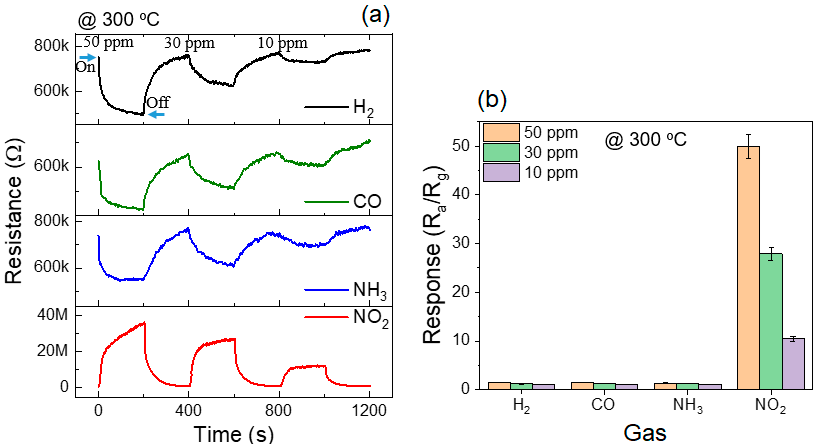
Figure 11. ( a ) Dynamic resistance graphs of Au ‐ decorated ZnO ‐ PANI (25 wt.%) composite nano ‐